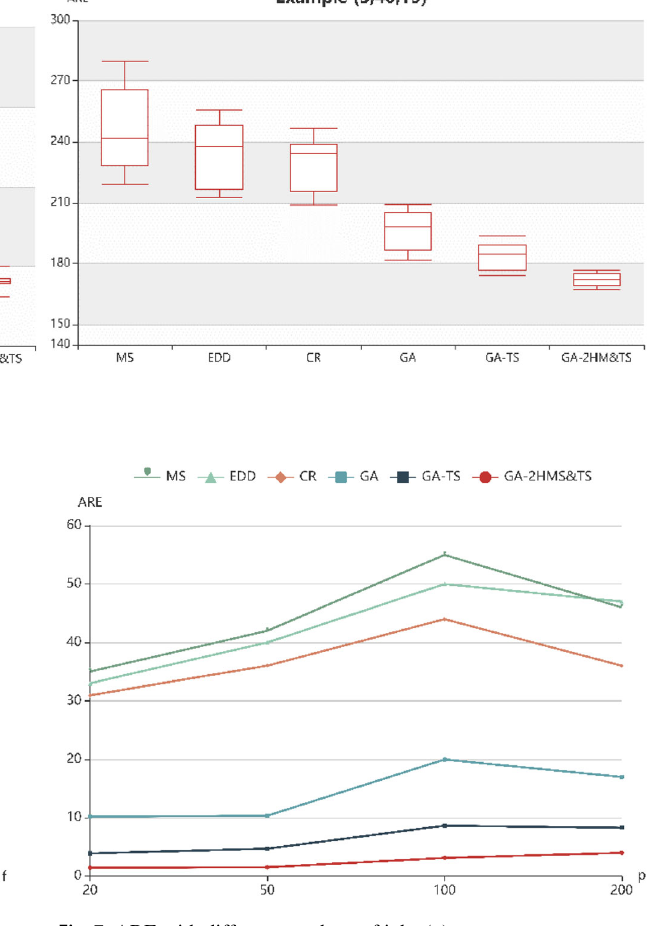
Fig. 5 ARE with different numbers of factories (f)